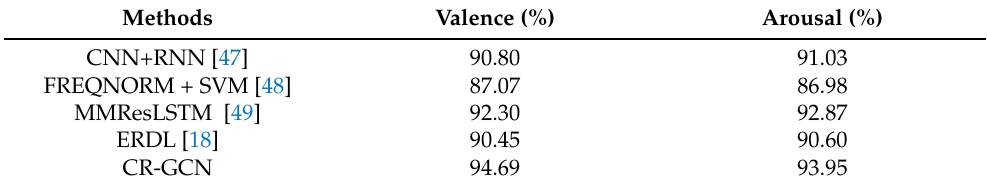
Table 3. Average classification accuracies of other methods in subject-dependent